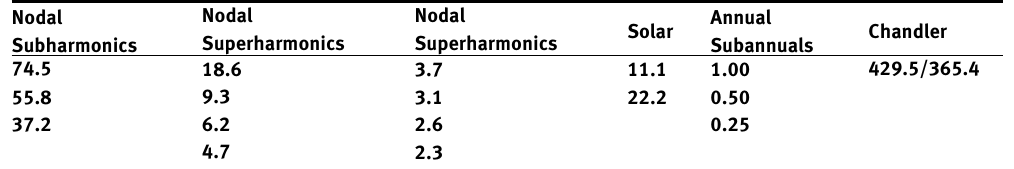
Table 1. Compounded Luni-Solar and other periodicities (yr.).